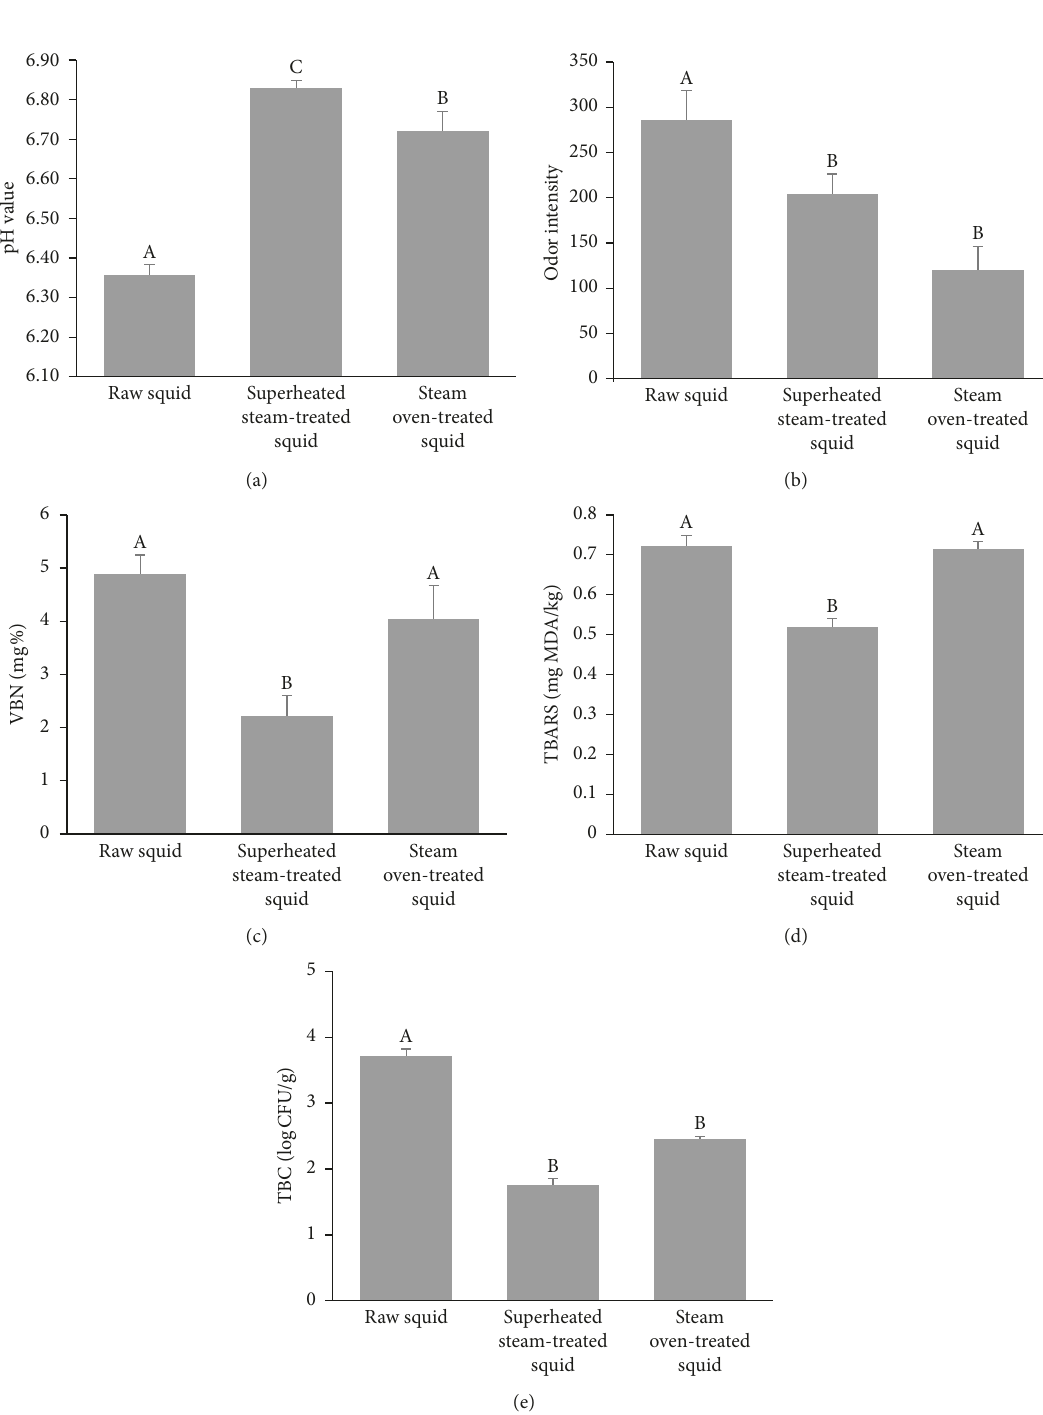
Figure 1: Physicochemical and microbial properties of raw, superheated steam-treated, and steam oven-treated squid. (a) pH value, (b) odor intensity, (c) VBN value, (d) TBARS value, and (e) TBC. Different letters (A–C) indicate significant differences among means by Tukey’s test at p < 0 . 05. Values are mean ± SD ( n �